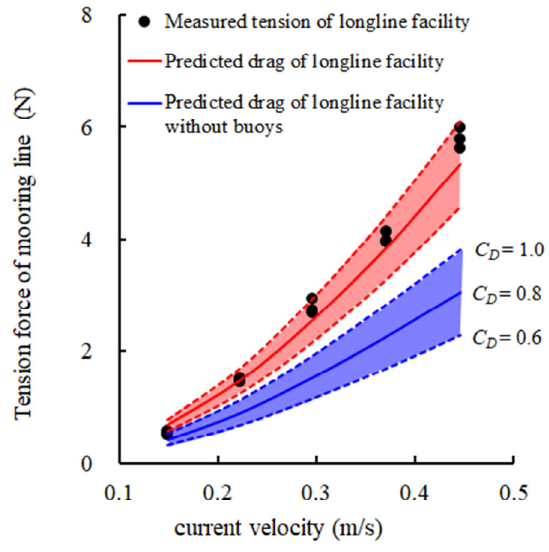
Figure 5. Relationship between tension force of mooring line of the longline aquaculture facility model with lantern nets and current velocity. Table 3. Information of the lantern net and buoy of the longline aquaculture facility with lantern nets in the calculation of tension mooring in the current conditions.